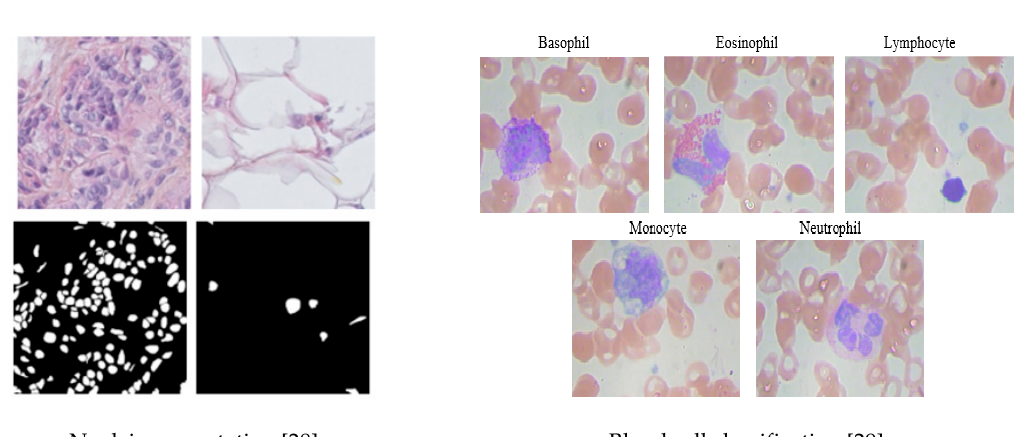
Figure 6. Example images where DL is applied successfully and achieved state-of-the-art performance. The images were taken from the corresponding references.